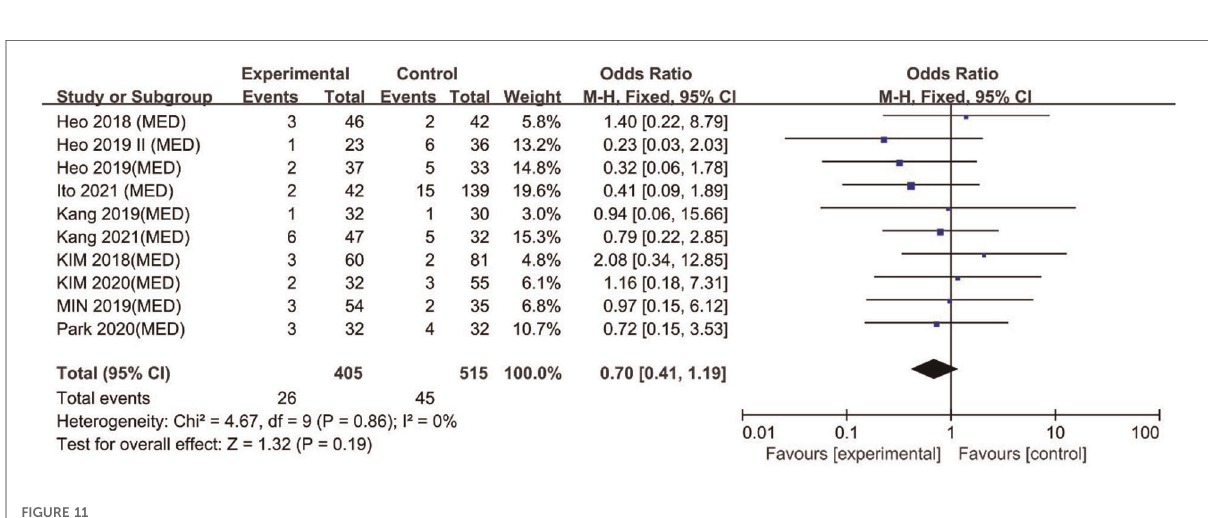
FIGURE 11 Forrest plot of complications UBE vs